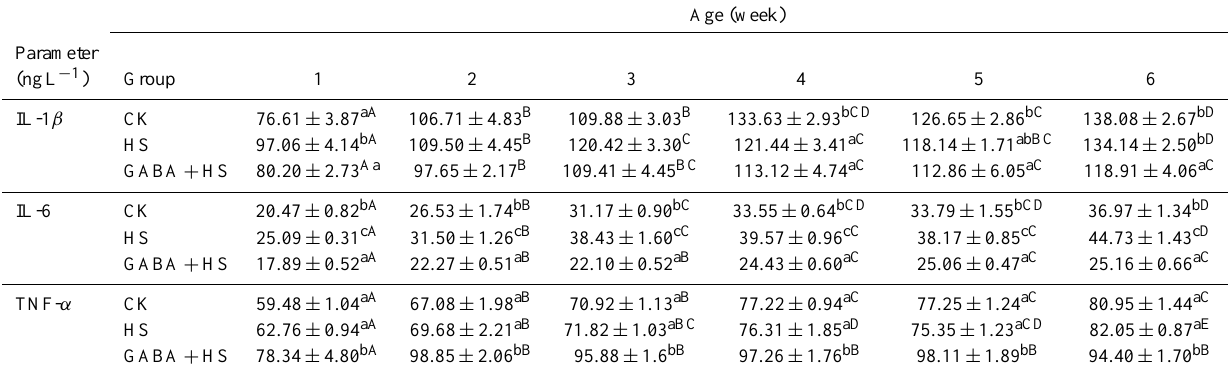
Table 3. Effects of GABA on the contents of IL-1 β , IL-6, and TNF- α in the BF of chicks under heat